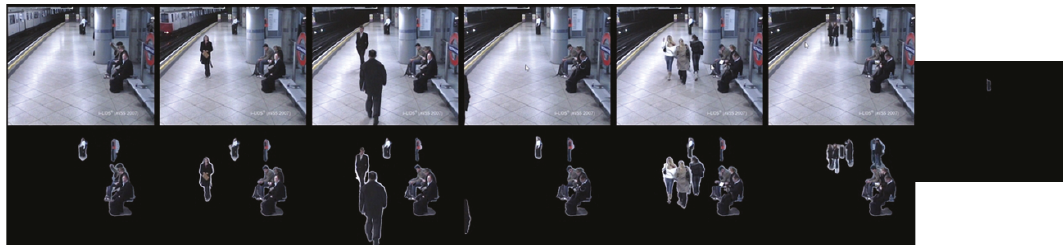
Figure 3: Foreground-mask sampling. The first row shows input frames while the second row shows corresponding foreground images. After obtaining the intersection result, two filters are applied to remove certain static regions which are not the luggage items. One filter is the human classifier introduced in Section 3, while the other removes unreasonably large regions. Image on the right represents the intersection of the n foreground images sampled over T seconds, and it was obtained after removing nonluggage